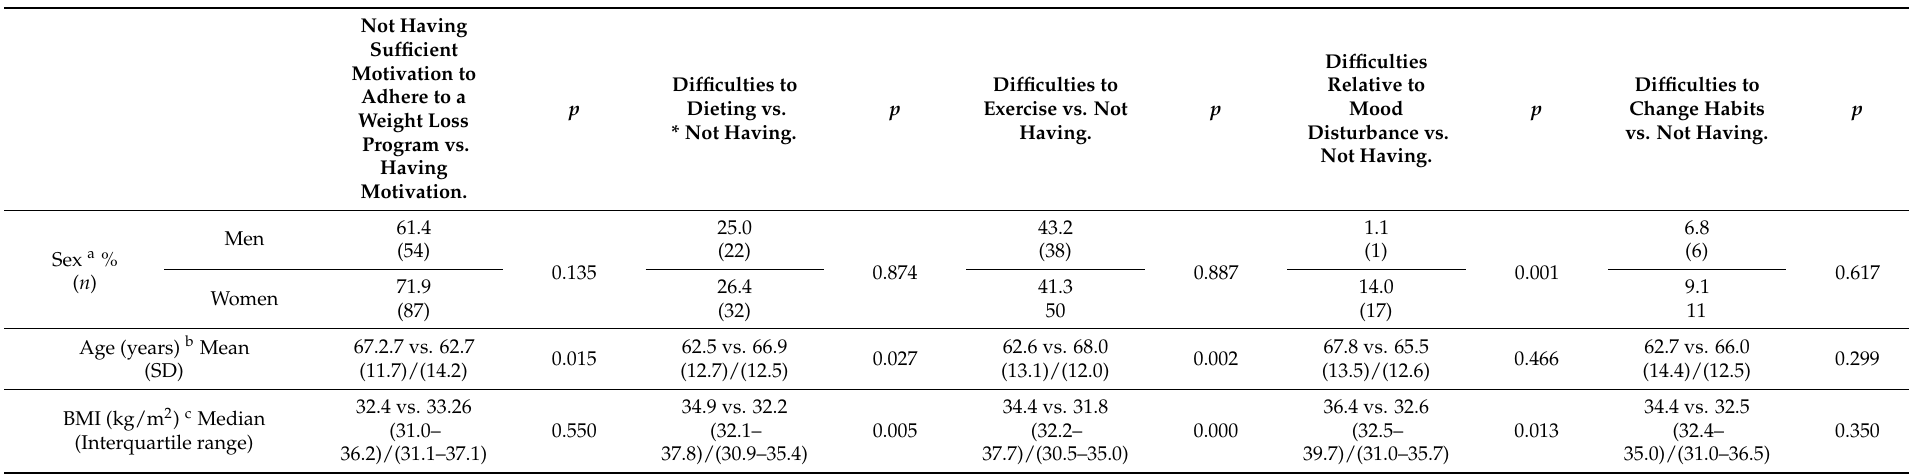
Difficulties to p Change Habits vs. Not Having.